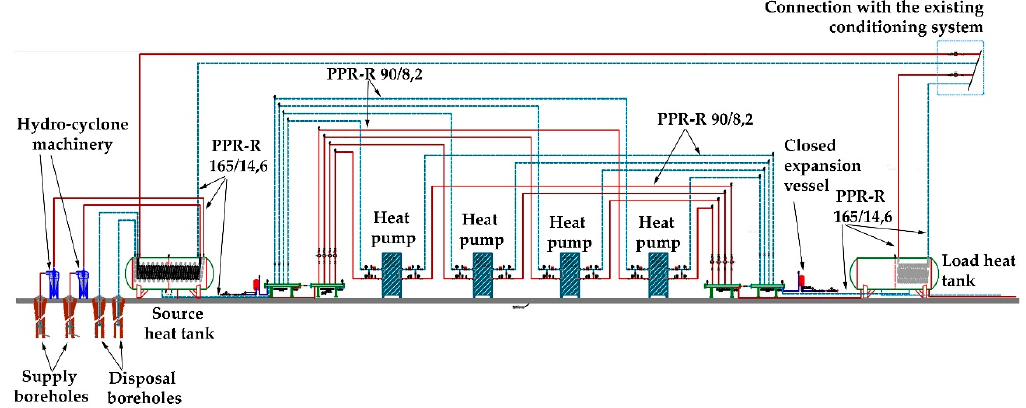
Figure 10. Construction and operation layout of the proposed open loop geothermal system.